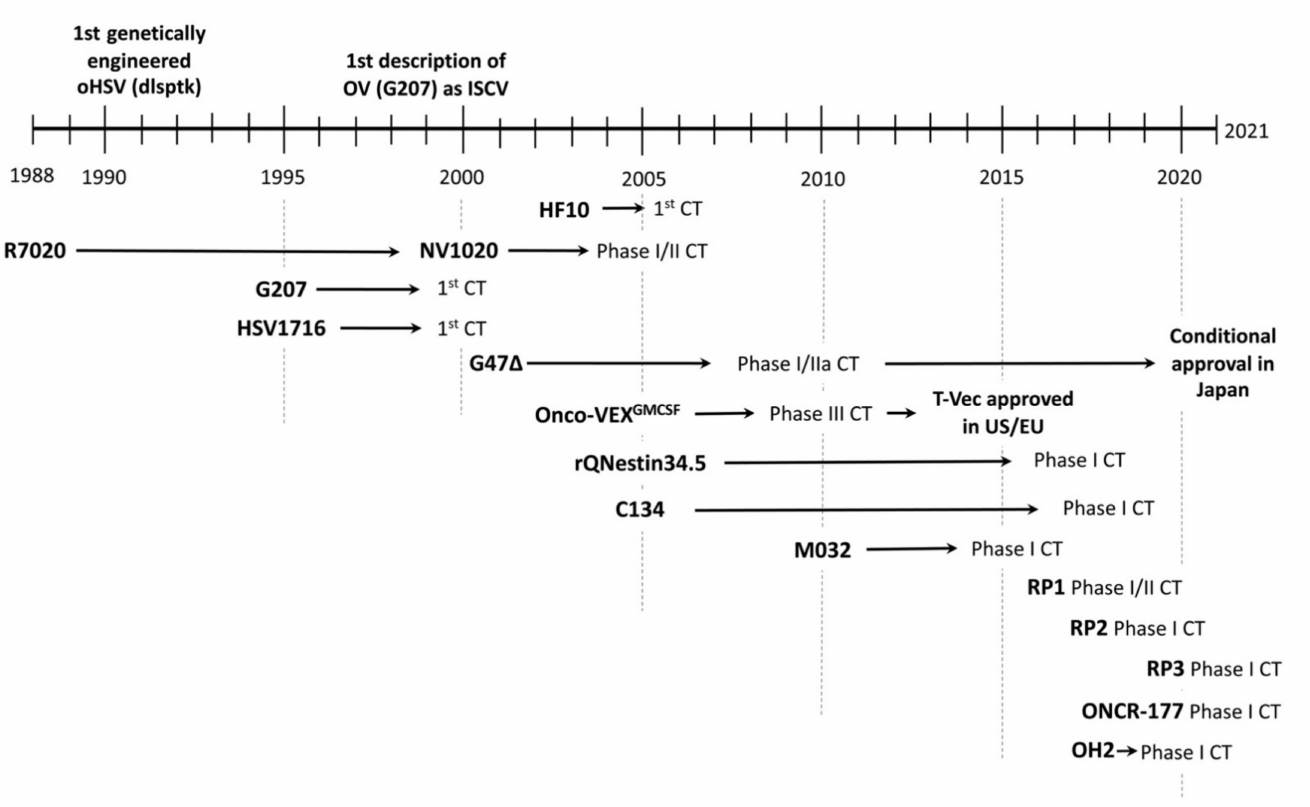
Figure 1. Development of oHSV: from discovery to clinical trial (CT) and approval as oncolytic agent. The center of the text corresponds to the